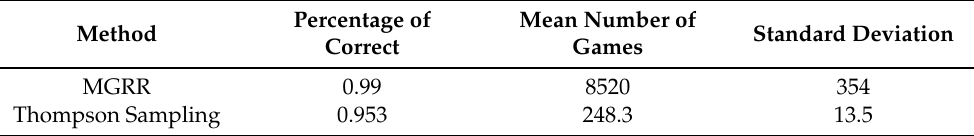
Table 4. Numerical example of Thompson sampling rule where strengths are randomly generated from exponential (1). Replication =